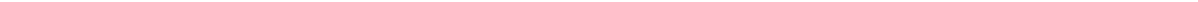
Fig. 7 NbBeclin1 via its AIM interacting with NbATG8a mediates NIb degradation to repress viral replication, and one C-terminal fragment of NbBeclin1 also inhibits viral replication by binding to NIb independent of autophagy degradation of NIb. a Co-localization of NbATG8a-CFP with NIb-YFP in the expression of empty vector ( + mock), Myc-tagged NbBeclin1 ( + NbBeclin1) or Myc-tagged NbBeclin1 AIM mutant ( + NbBeclin1 Δ AIM ) in N . benthamiana leaf cells. In fi ltrated leaves were treated with DMSO or concanamycin A (Con A) after 48 hpi and confocal images were taken at 10 h after treatment. Bars, 25 μ m. b , c Co-IP analysis of the association of NIb with NbATG8a in the presence of Myc-NbBeclin1 or Myc-NbBeclin1 Δ AIM in planta. N . benthamiana leaves were agroin fi ltrated with the plasmids indicated. Leaf protein extracts were incubated with GFP-Trap ® _MA magnetic agarose beads (ChromoTek). Samples before (Input) and after (IP) immunopuri fi cation were analyzed by immunoblotting using GFP, HA, or Myc antibody. d Total protein extracts from the N . benthamiana leaves expressing the indicated recombinant plasmids were subjected to immunoblotting analysis using GFP (@GFP) or Myc antibody (@Myc). Minus sign ( − ) means that NIb-YFP or NIb- Δ GDD-YFP was expressed alone. All immunoblotting assays in this fi gure were repeated at least three times, and one representative blot was shown. CBB staining of Rubisco large subunit serves as a loading control. Yellow asterisks indicate the expected sizes. e Quanti fi cation of TuMV RNA levels by qRT-PCR. RNA was extracted from leaves in fi ltrated with TuMV together with Vec, NbBeclin1, biological replicates) and are presented as arbitrary units relative to Vec. According to Duncan ’ s multiple range test ( P = 0.01), the means do not differ signi fi cantly if they are indicated with the same letter. f The C1 domain and C4 domain in the C-terminal region of NbBeclin1 interact with NIb in the Y2H assay. A series of truncated NbBeclin1 proteins from NbBeclin1-C are indicated. g The truncated proteins of NbBeclin1-C fail to degrade NIb. Immunoblotting analysis of the total protein extracts from the N . benthamiana leaves expressing the plasmids indicated. Minus sign ( − ) means that NIb- YFP was expressed alone. Yellow asterisks indicate the expected